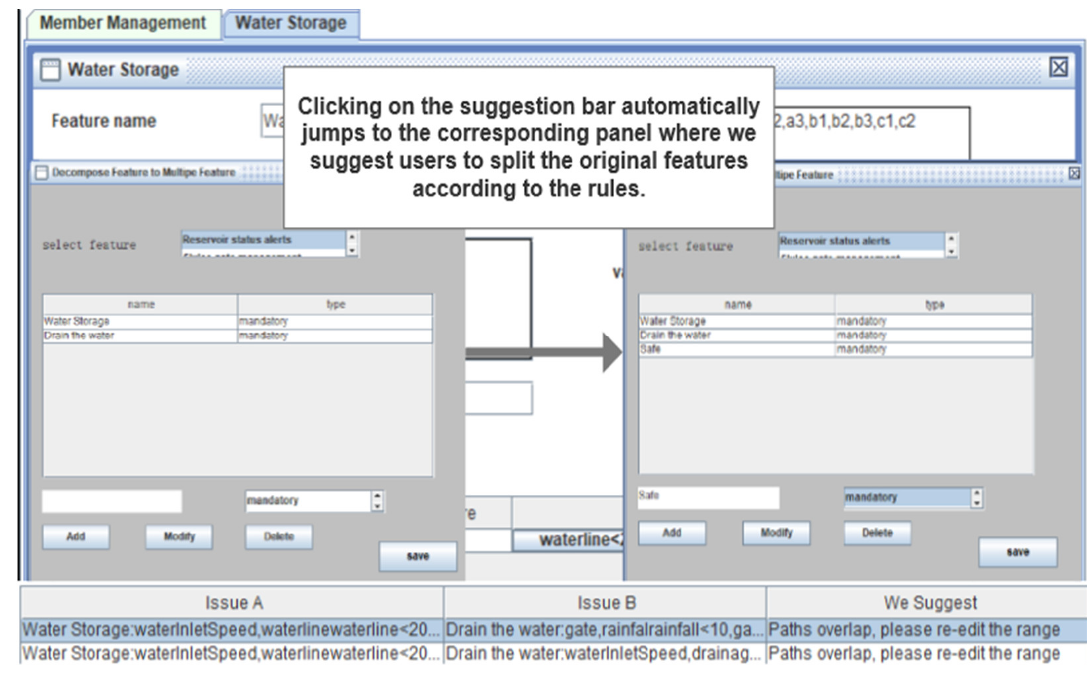
Figure 7. Functional path error message.